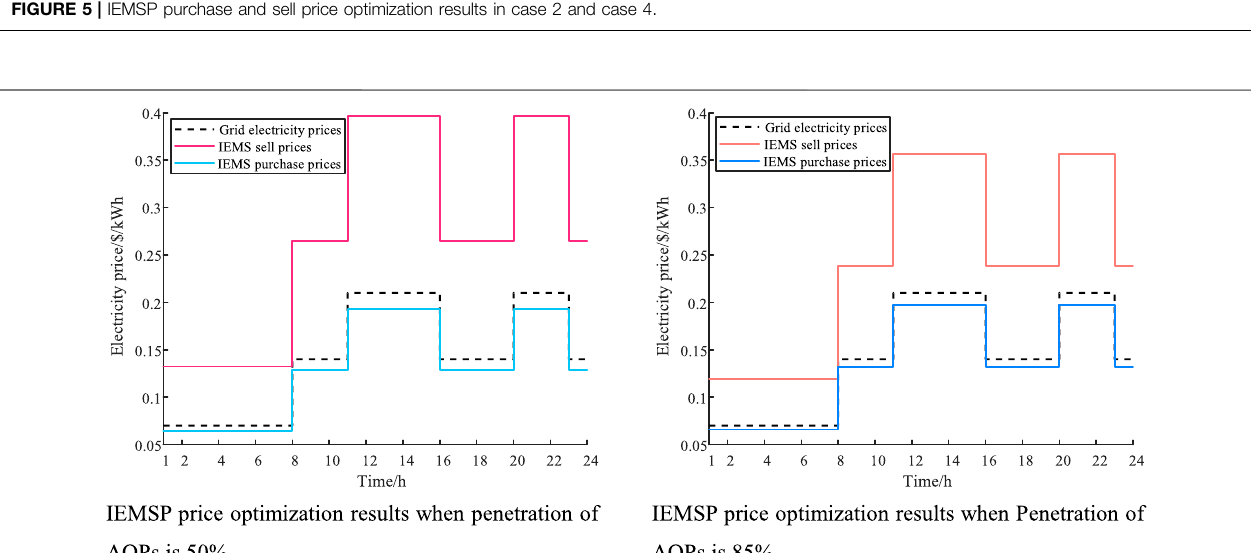
FIGURE 5 | IEMSP purchase and sell price optimization results in case 2 and case 4.